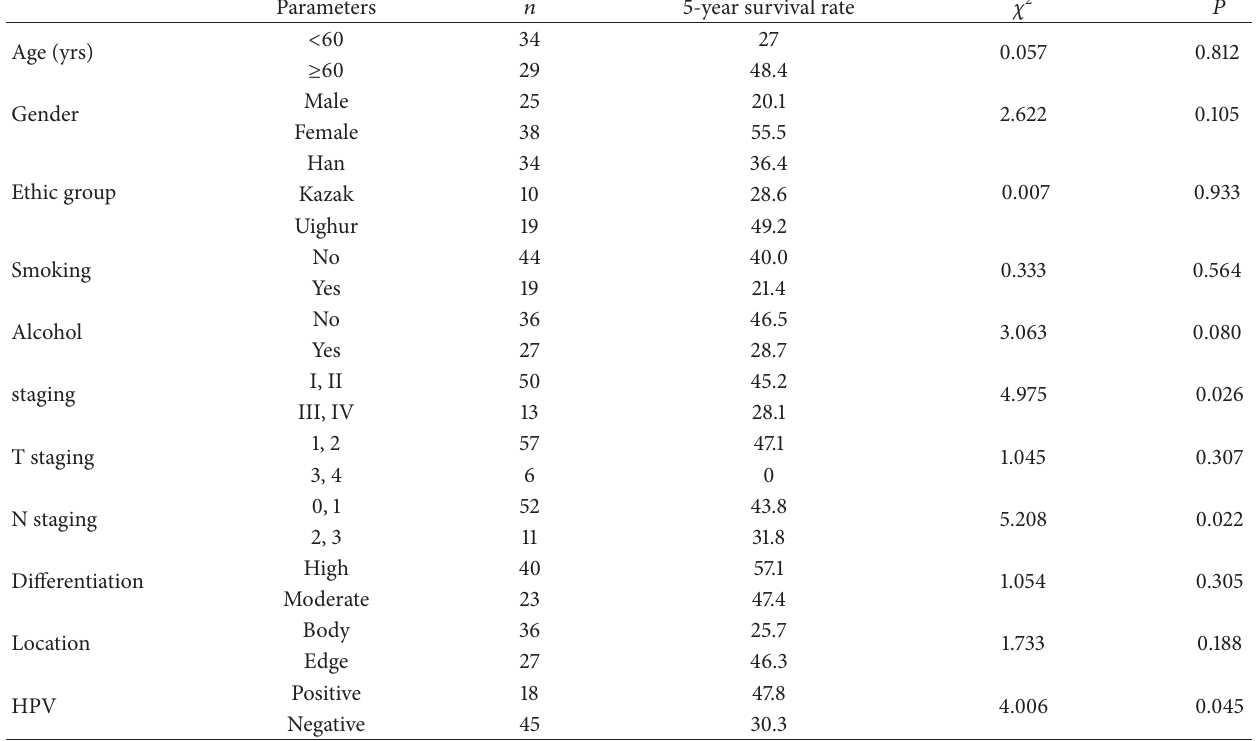
Table 1: The prognosis analysis of 63 cases of patients with tongue squamous cell carcinoma.